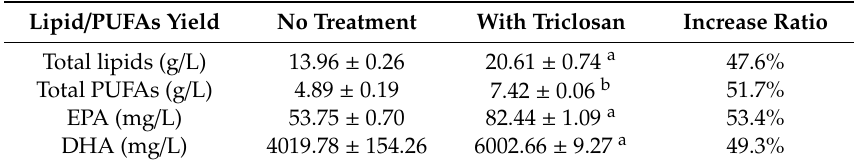
Table 1. Comparison of the total lipid and PUFAs yields between the control group and 8 µ M triclosan treatment at 24 h. Significant di ff erence between control and triclosan treatment group is indicated at p < 0.05 (a), p < 0.01 (b), or p < 0.001 (c) level. All data are expressed as mean ± S.D. of three independent experiments.